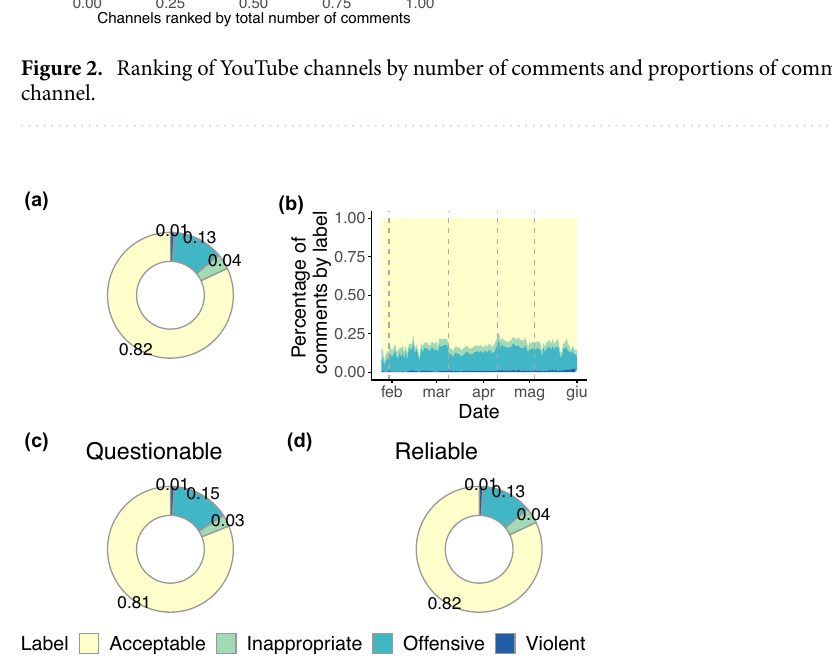
Figure 3. Proportion of the four hate speech labels in the whole dataset ( a ) over time ( b ), and for questionable ( c ) and reliable ( d ) YouTube channels. Panel b displays four dashed lines in correspondence of events of paramount relevance for the year 2020 in Italy. The first line is placed on 30/01/2020 when the first two cases of COVID-19 were detected in Italy. The second line is placed on 09/03/2020 when the Prime Minister enforced the first lockdown to the whole nation. The third line is placed on 10/04/2020 when the Prime Minister communicated to the nation an extension of the lockdown until May the 3rd. The fourth line is placed on 04/05/2020 when the “phase 2” (i.e., the suspension of the full lockdown) began. Interestingly, we note a higher share of Acceptable comments between the second and third lines, that is during the lockdown, perhaps due